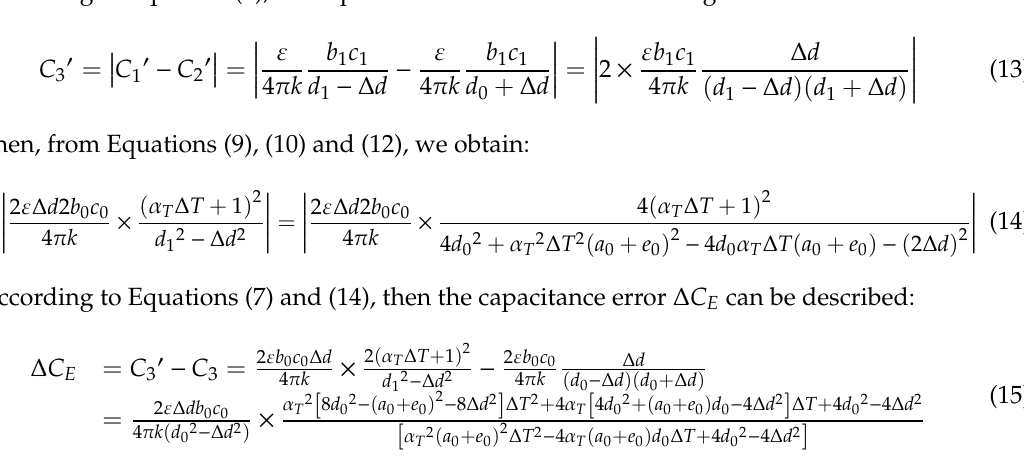
ω = ω   . ( a ) top view; ( b ) side view. Figure 6. Deformation of the combs when T = T T T  and 0 . ( a ) top view; ( b ) side 1 and 1 0